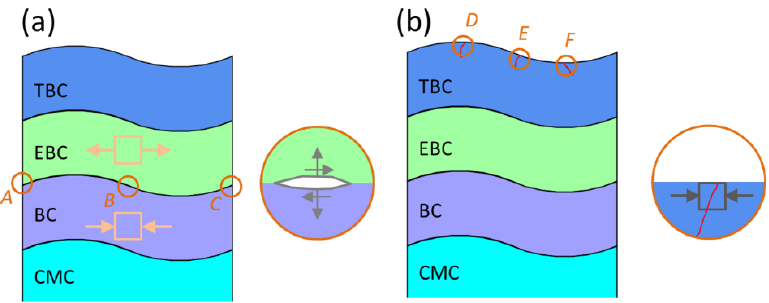
Figure 11. Analysis of possible failure mode for the investigated coatings induced by ( a ) thermal residual stress and ( b ) operating thermal stress.